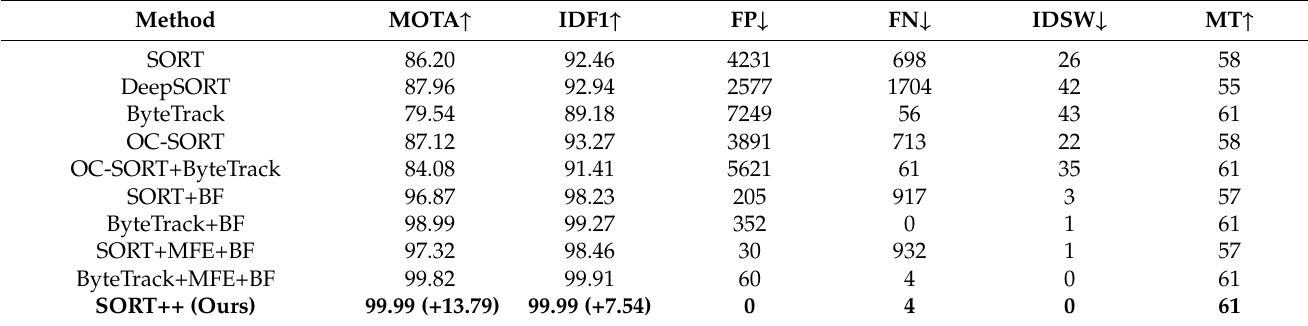
Table 9. Comparison of the state-of-the-art methods on the Test1 (Night)